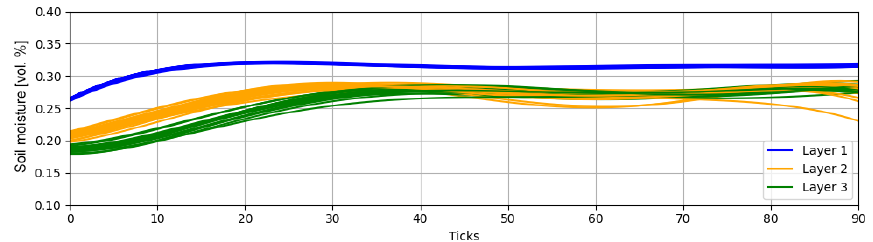
Figure 6. Influence of randomly chosen starting point. Calculated with 20 runs and a model set-up with two different soil types.